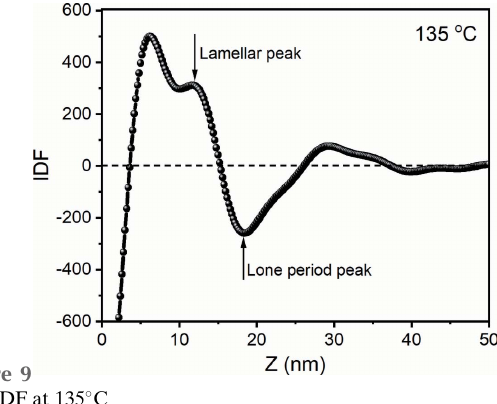
Figure 9 The IDF at 135 (cid:3)